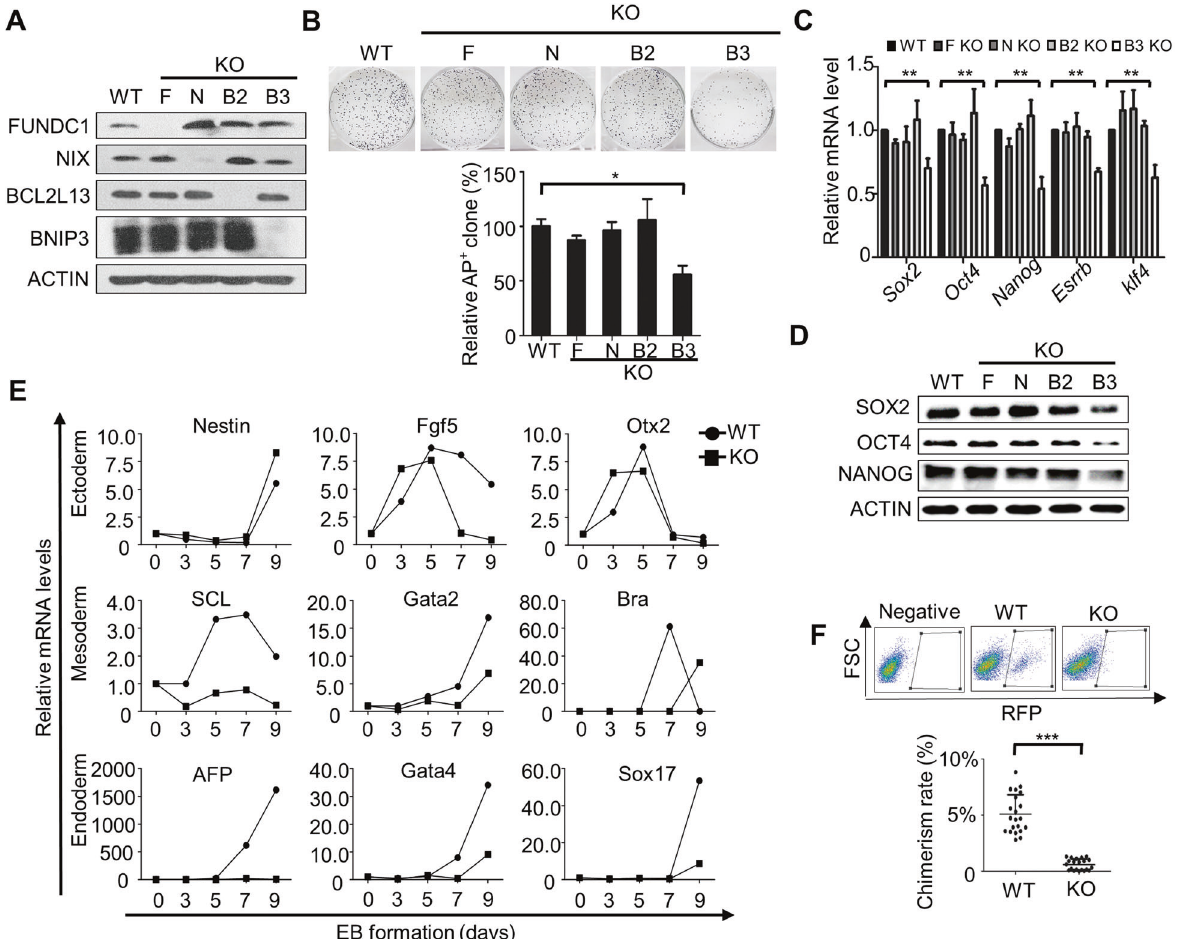
Fig. 1 Knockout of Bnip3 impairs self-renewal and pluripotency of ESCs. A Proteins from wild-type (WT), Fundc1 − / − (F), Nix − / − (N), Bcl2l13 − / − (B2), and Bnip3 − / − (B3) ESCs were detected by western blot. B Colony-formation assay of wild-type, Fundc1 − / − , Nix − / − , Bcl2l13 − / − , and Bnip3 − / − ESCs. Data are shown as mean ± SD, n = 3; * P < 0.05; Student ’ s t test. C Knockout of Bnip3 impairs ESC pluripotency. Real-time PCR analysis of the expression of pluripotency genes in WT and mitophagy receptor knockout ESCs. Data are shown as mean ± SD, ** P <